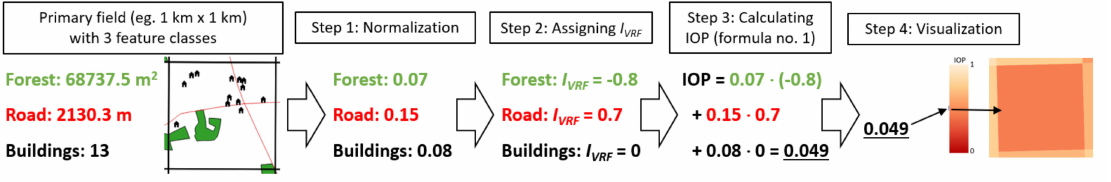
Figure 3. Visualization of the algorithm determining the IOP for sample data according to the VRF